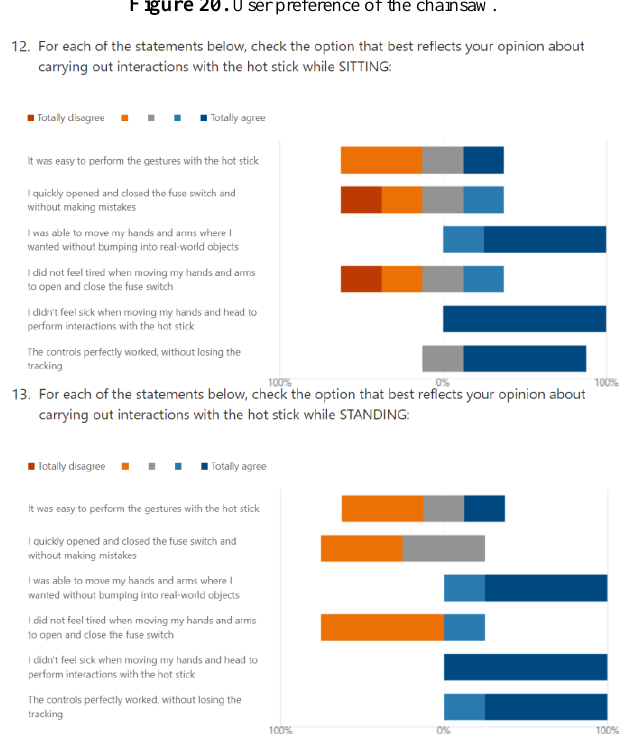
Figure 21. User preference of the hot